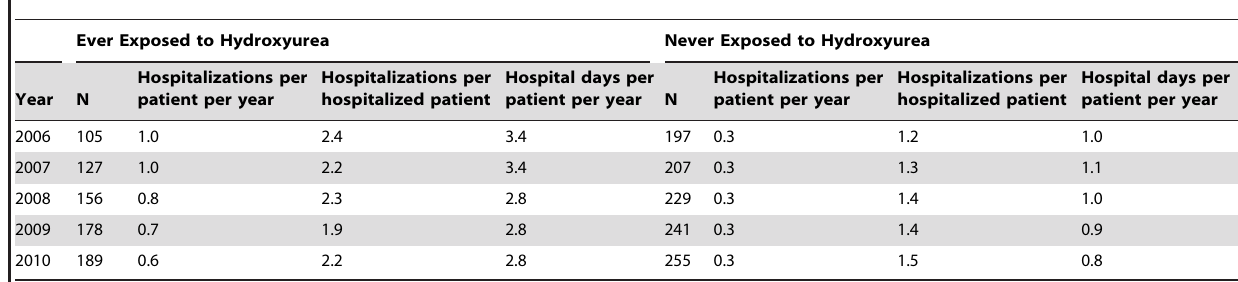
Table 2. Hydroxyurea usage and hospitalizations.